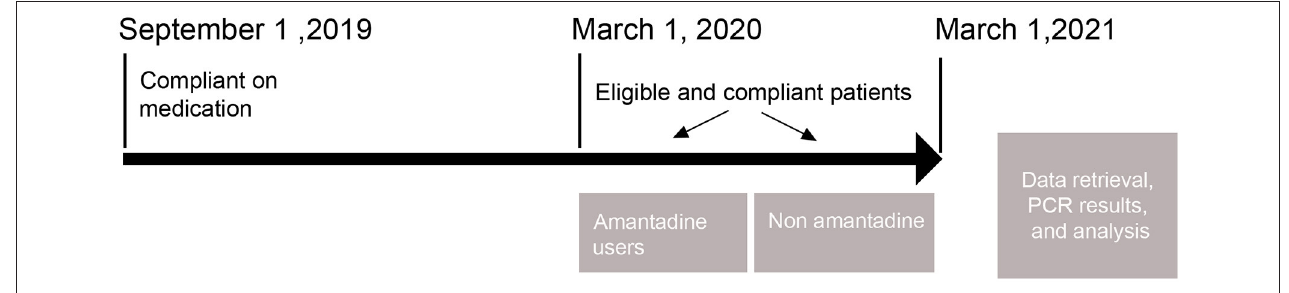
FIGURE 1 | Study diagram.